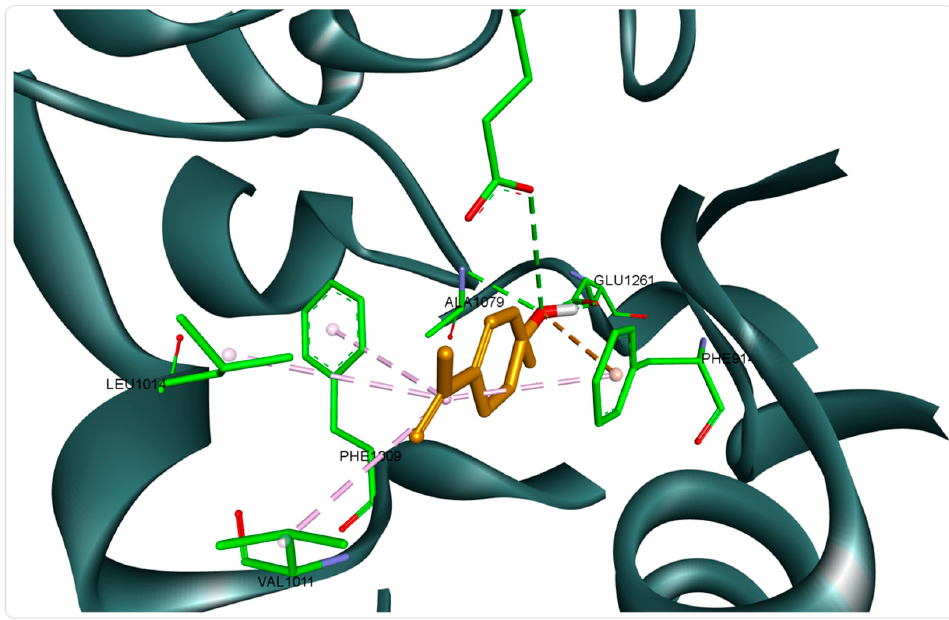
Figure 2. Structure of xanthine oxidase (3NRZ) in complex with cis -p-Mentha-2,8-dien-1-ol; hydrogen bond interactions are depicted as green dotted lines, hydrophobic interactions as purple dotted lines, and electrostatic interactions in orange; interacting amino acids are shown as green sticks.